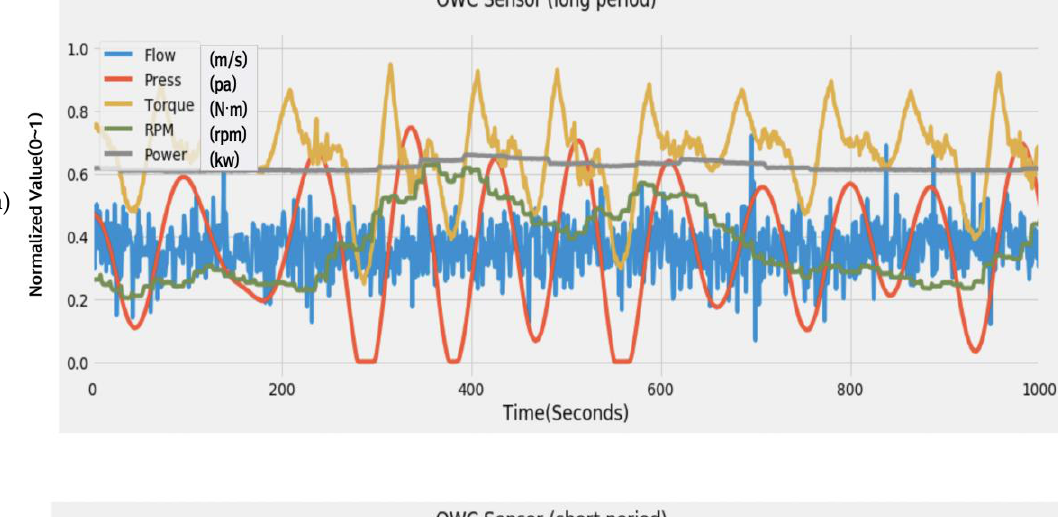
Figure 7. Analysis with SWAN. The utilization of wave height data is limited owing to the time-delay problem, con- sidering the 30 min intervals of the measured wave height. The reason for using OWC and WEC data is that, as shown in Figure 7 , OWC generates pressure energy from the actions of wave energy, and the pressure is converted into energy such as flow velocity to operate the turbines; thus, it is judged that there is a close correlation between the two sets of data. In order to analyze the pressure change due to air flow in both directions in the OWC chamber, the data samples were collected every second; the minimum interval between OWC data and the wave height data with measured electrical power. Table 5 shows the result of correlation analysis between OWC data and WEC data acquired in 1 s intervals for 48 h. From the analysis, there is a high positive correlation between the pressure data of OWC and WEC data, such as electrical energy. Therefore, it can be assumed that the OWC chamber pressure is one of the key parameters for the operation of WEC; thus, data prediction using machine learning can be considered instrumental in the operation of OWC–WEC.